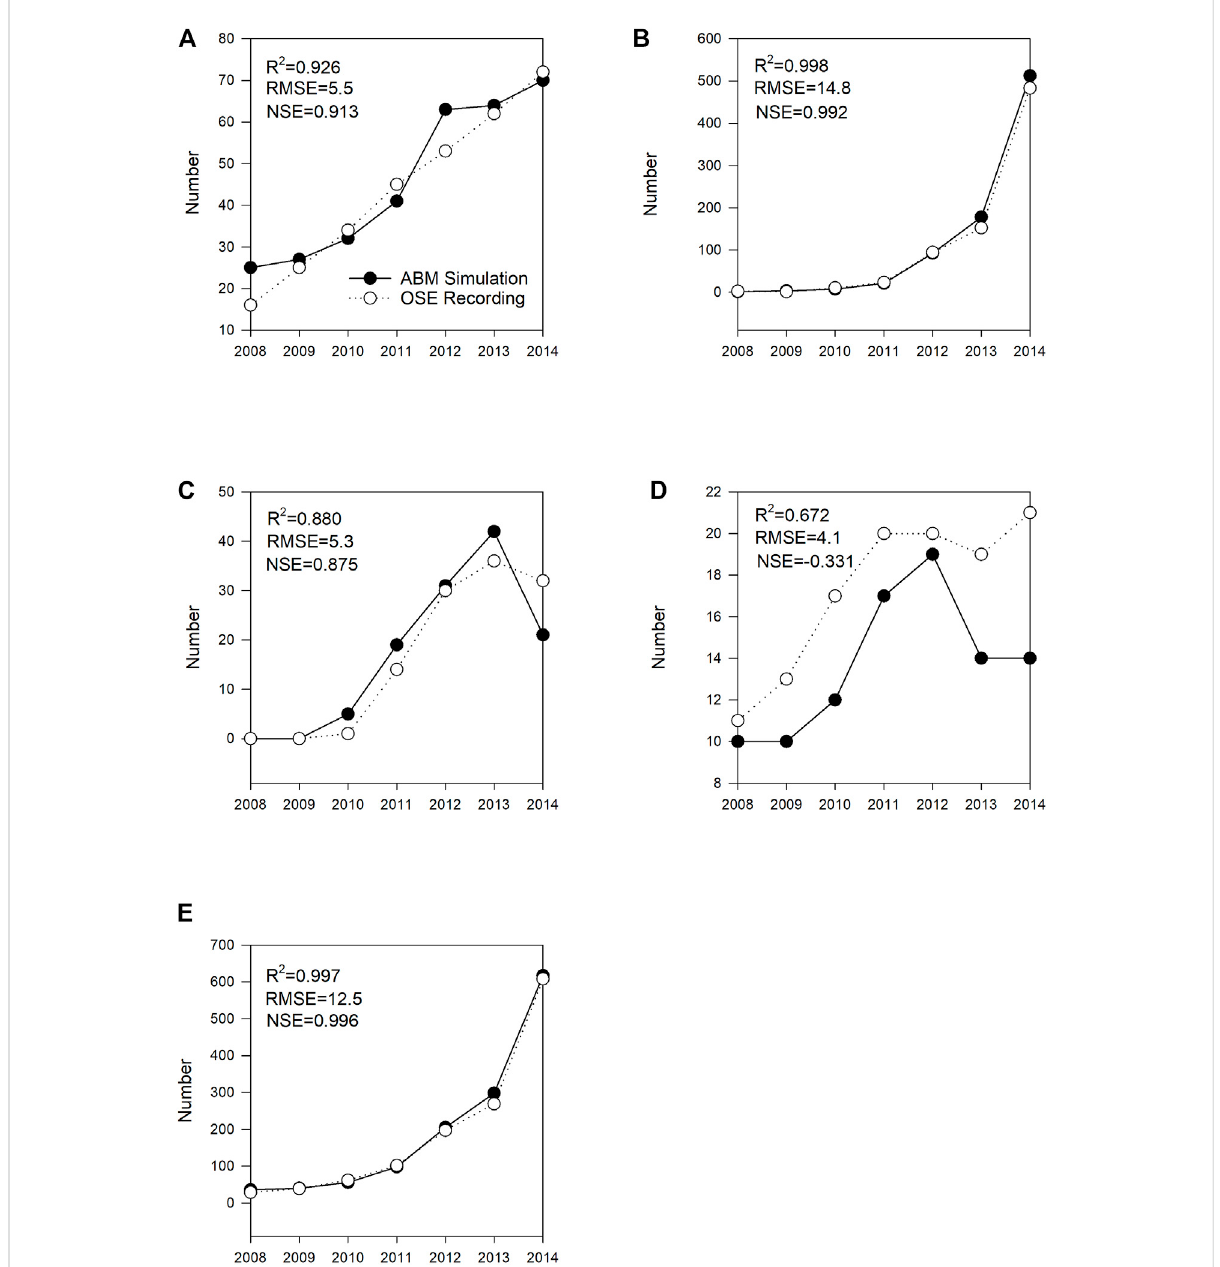
FIGURE 5 Graphical comparisons of the actual and model-simulated numbers of (A) permanent, (B) temporary, (C) irrigation transferred, (D) municipal/ co-op, and (E) all types of water depots. Notes: ABM – agent-based model, OSE – Of fi ce of the State Engineer, RMSE – Root Mean Square Error, NSE – Nash-Sutcliffe Ef fi